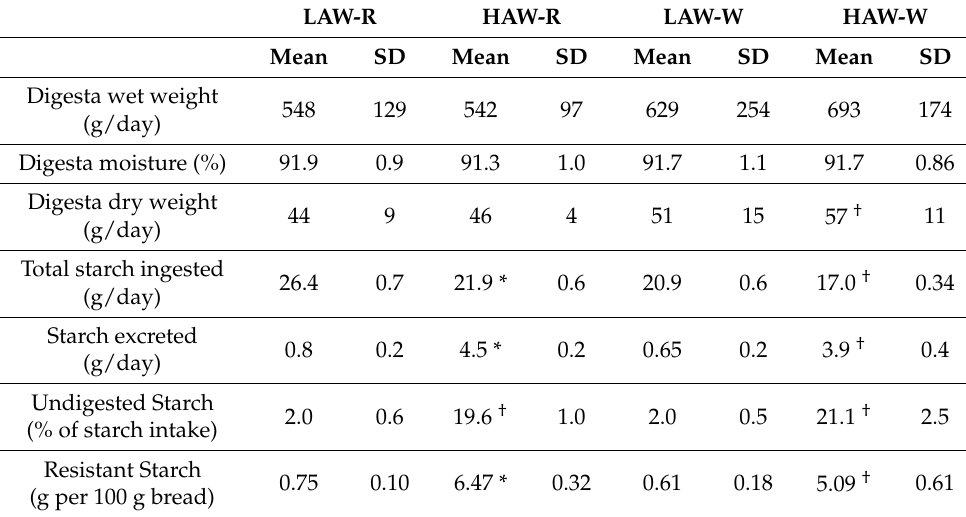
Table 1. The effect of breads made from LAW and HAW flours on stoma digesta output and composition and starch digestibility in human ileostomates.